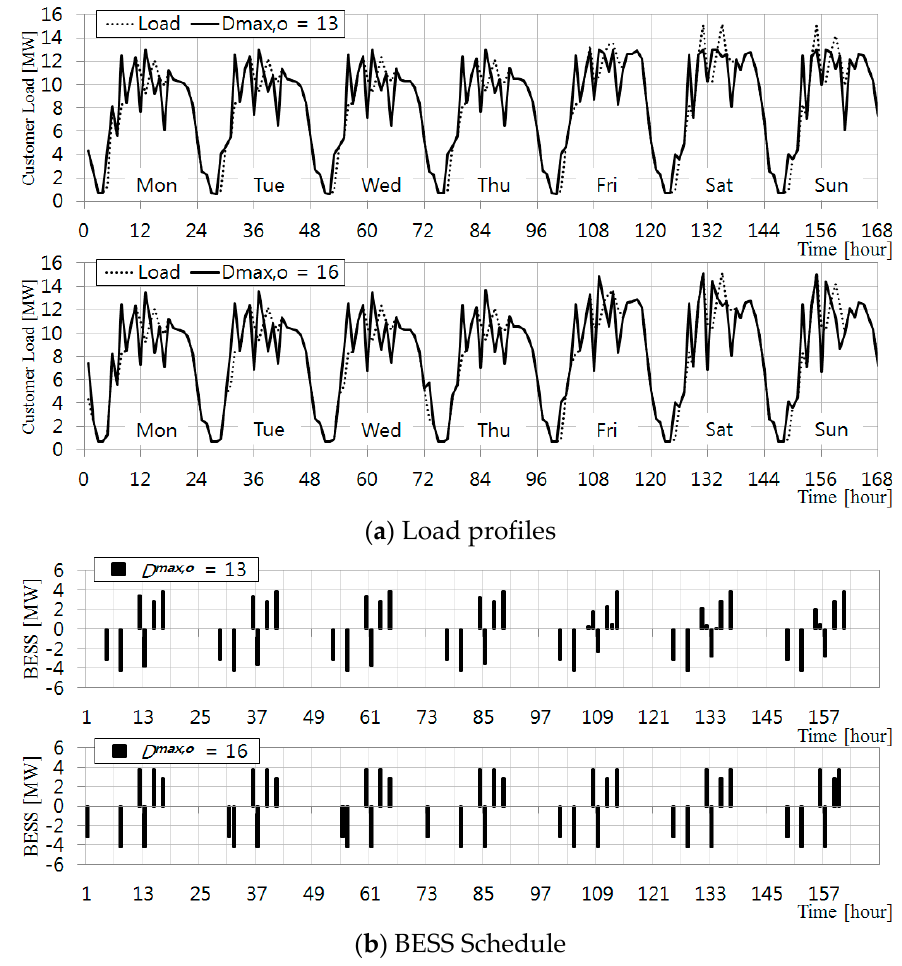
Figure 10. Daily operation results for customer electric bill minimization which considers the historical peak-value.